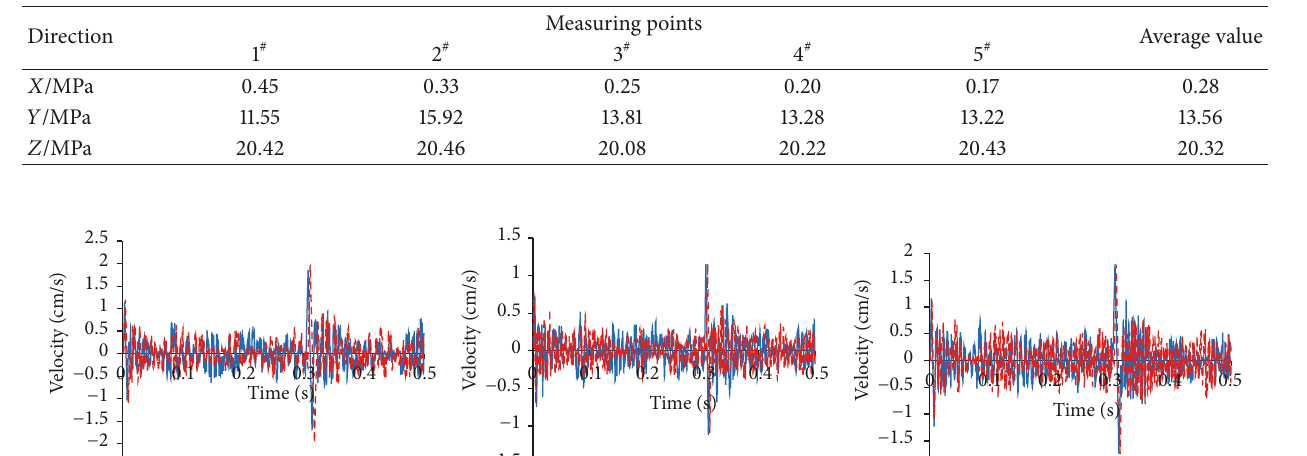
Table 4: Stress values of five measuring points of rock-anchored beam.